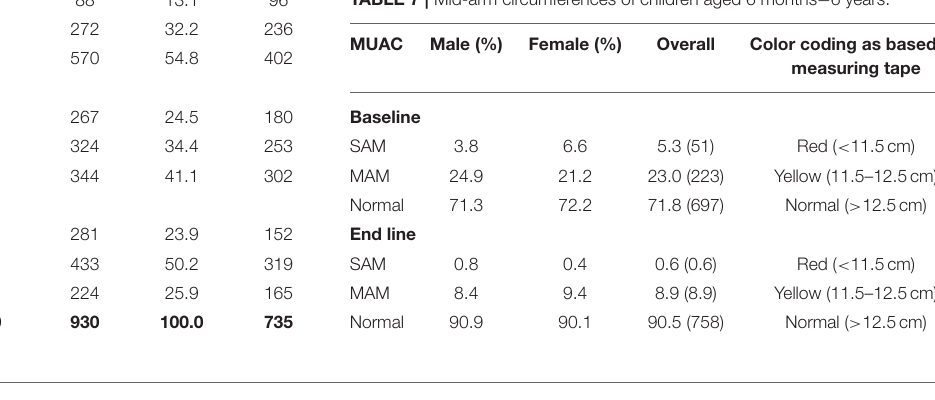
TABLE 7 | Mid-arm circumferences of children aged 6 months − 6 years.